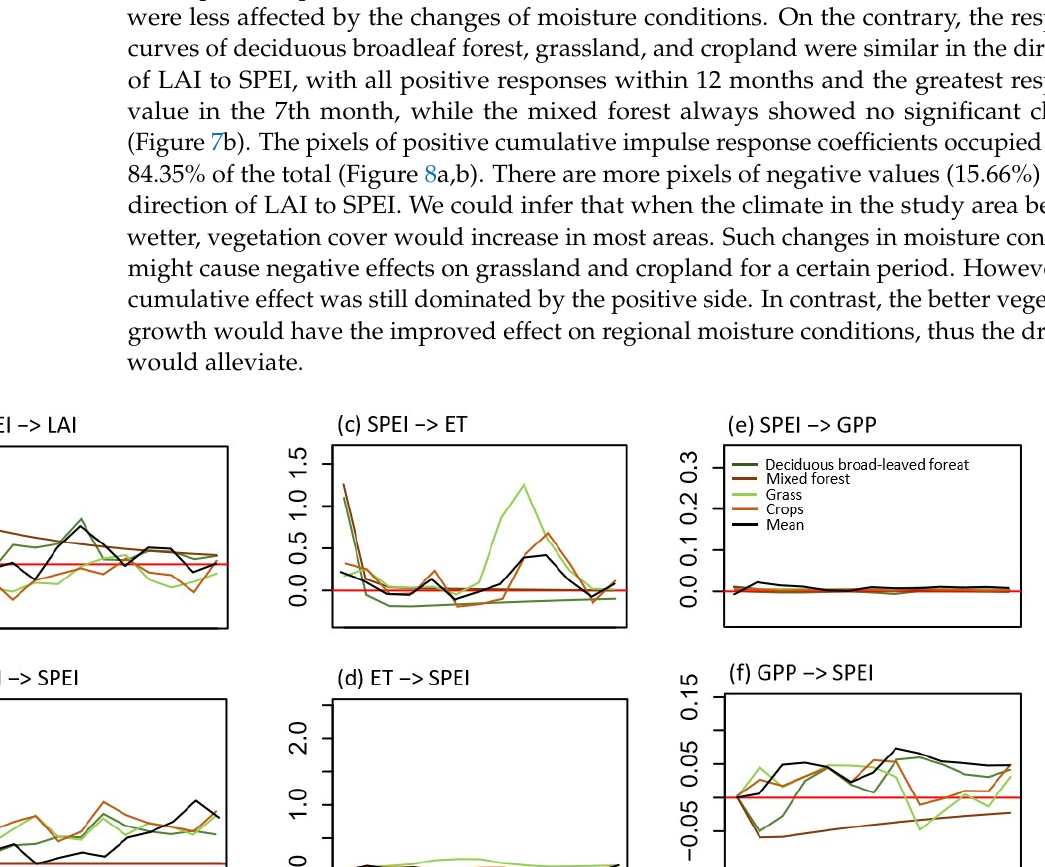
Figure 8. The cumulative impulse coefficients in 12 months after each group of variables were im- pacted with each other, i.e., SPEI and LAI ( a , b ), ET ( c , d ), GPP ( e , f ). 3.3.2. SPEI and ET Figure 7c illustrates the impulse response of SPEI on ET for different vegetation types. When SPEI increased, the ET of mixed forest and deciduous broadleaf forest had the maximum positive response at the beginning of the shock. The responses decreased rapidly within the following month. Subsequently, the response value of ET in mixed for-